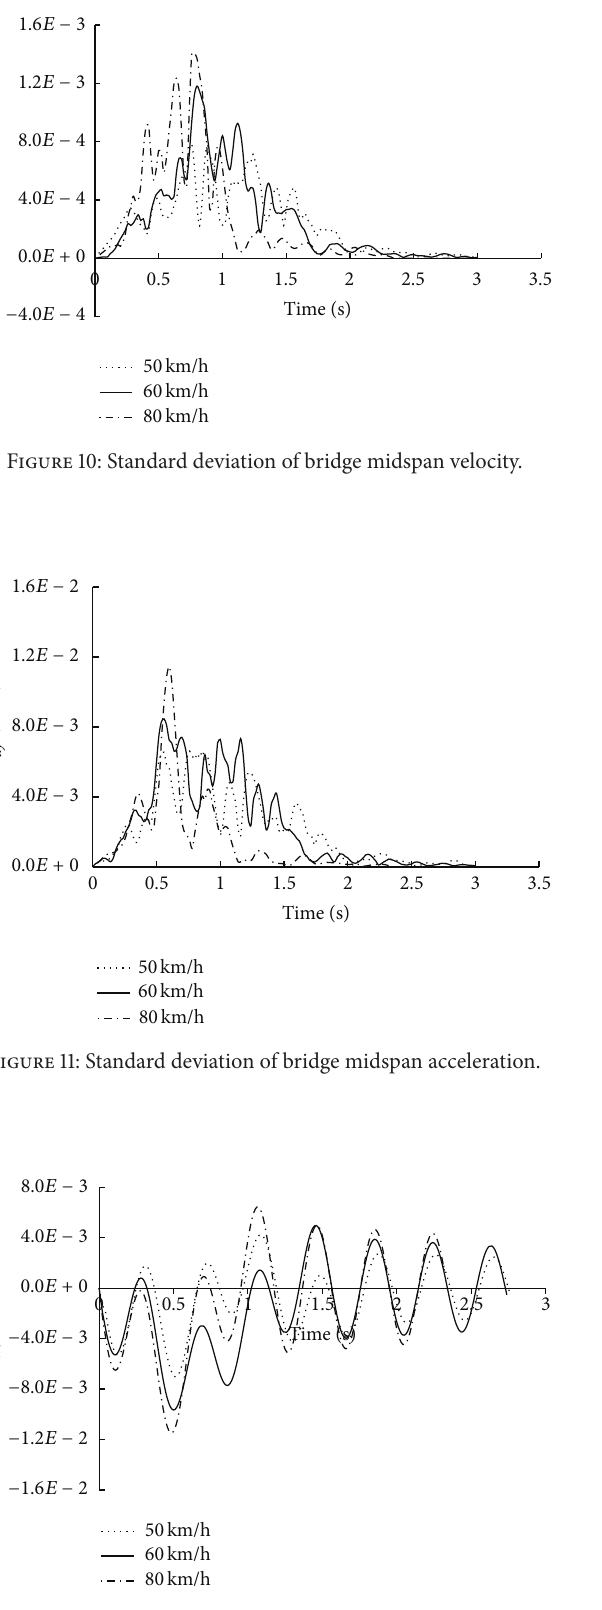
Figure 12: Mean displacement of vehicle C.G.